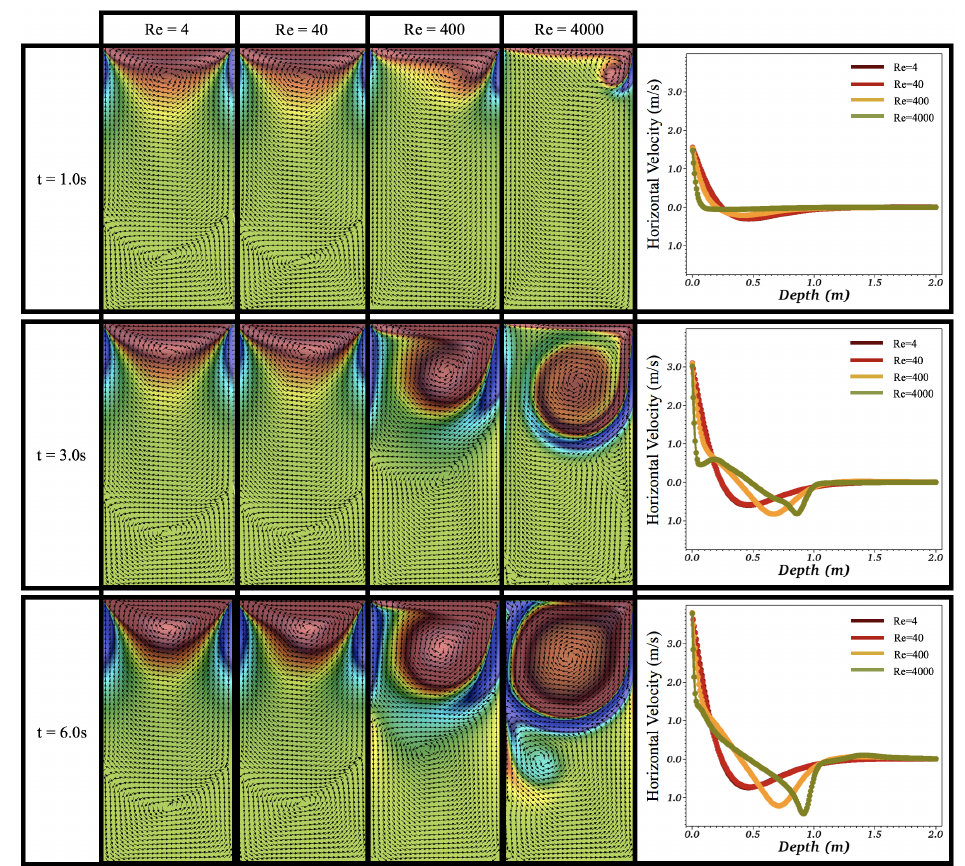
Figure 23. A comparison of vorticity, velocity field, and horizontal velocity measurements down the center of the cavity between cases of Re = 4,40,400, and